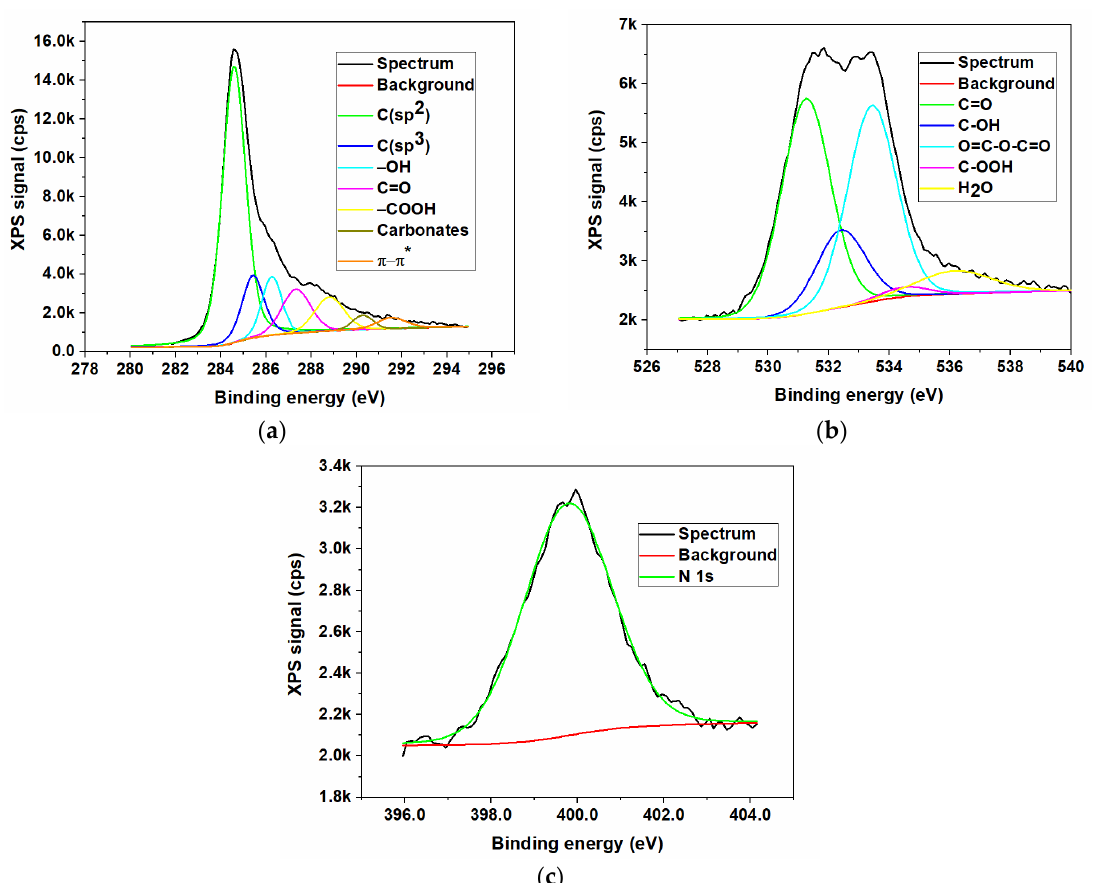
Figure 4. XPS high resolution spectra for nitrogen-doped graphene oxide synthesized using ammonia (N/GO_A); ( a ) Carbon (C1s); ( b ) Oxygen (O1s); ( c ) Nitrogen N1s.